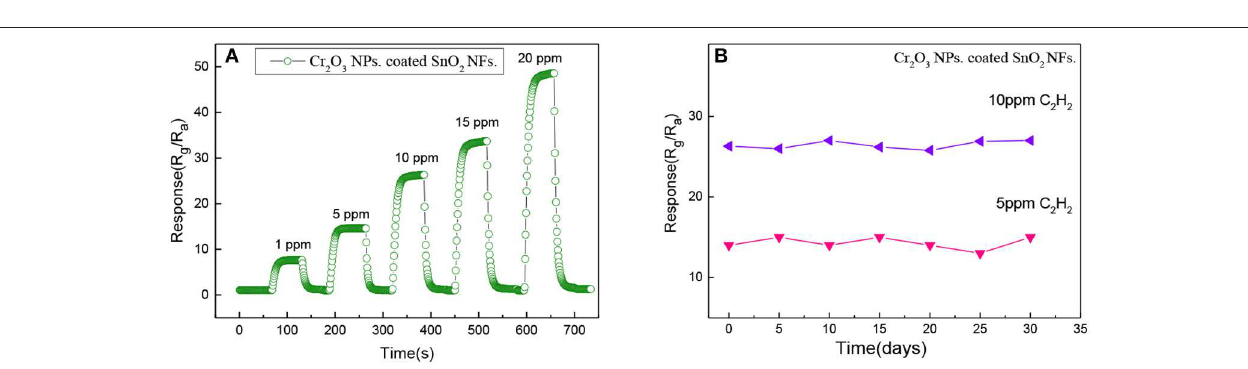
Frontiers in Materials |